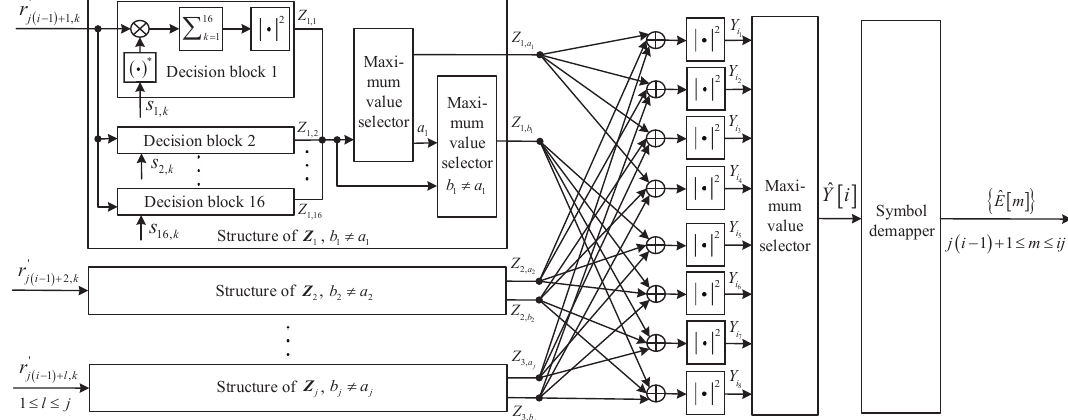
Figure 1. The receiver structure of our proposed multiple-symbol detection (MSD)